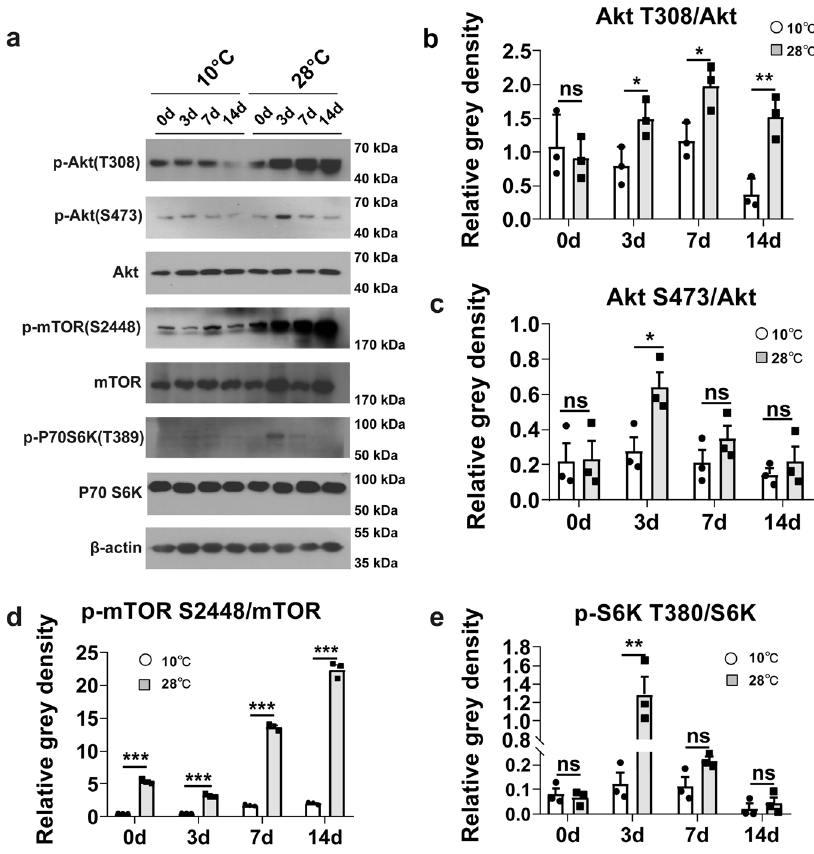
Fig. 2 Akt/mTOR pathway was involved in the regeneration process. a Protein expression of Akt, p-Akt (Ser473, Thr308), p-mTOR (Ser2448), mTOR, p-P70 S6K (Thr389), P70 S6K in the high and low temperature groups on days 0, 3, 7 and 14. b – e Relative expression of p-Akt (Thr308)/Akt, p-Akt (Ser473)/Akt, p-P70 S6K (Thr389), p-mTOR (Ser2448)/mTOR, p-P70 S6K (Thr389)/P70 S6K in Fig. 2a. Values represent mean ± SD, N = 3, ns p >